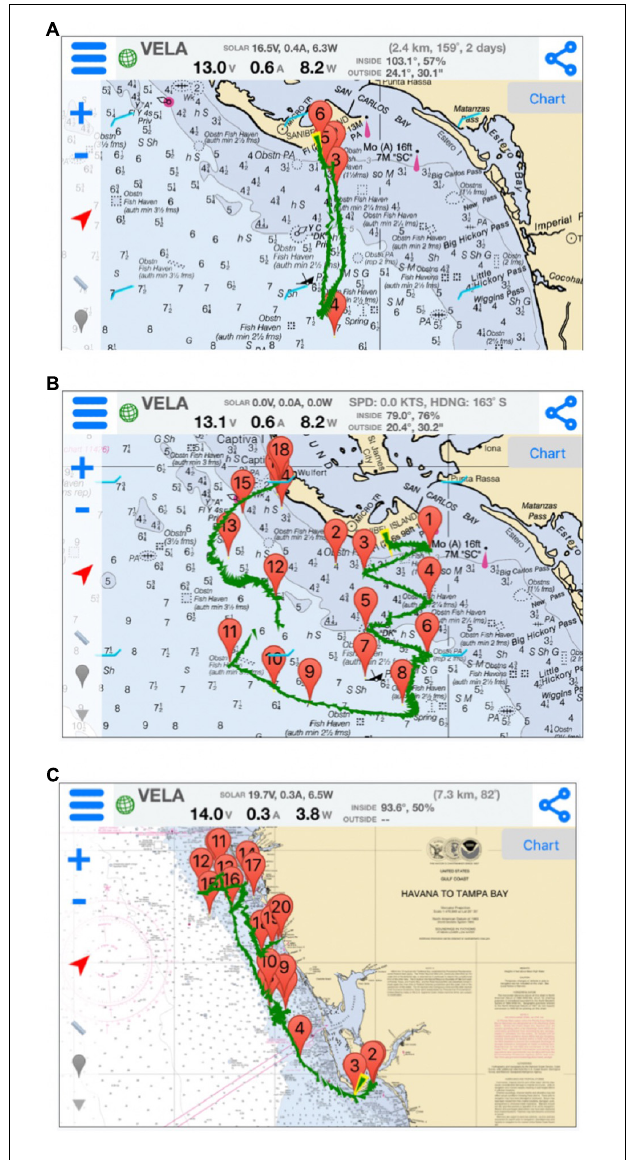
FIGURE 3 | Screenshots of the iOS control software running on an iPad, illustrating the three ASV tracks in southwest Florida for the purposes of harmful algal bloom monitoring from deployments between (A) December 18 and 19, 2017, (B) December 20 and 23, 2017, and (C) January 31